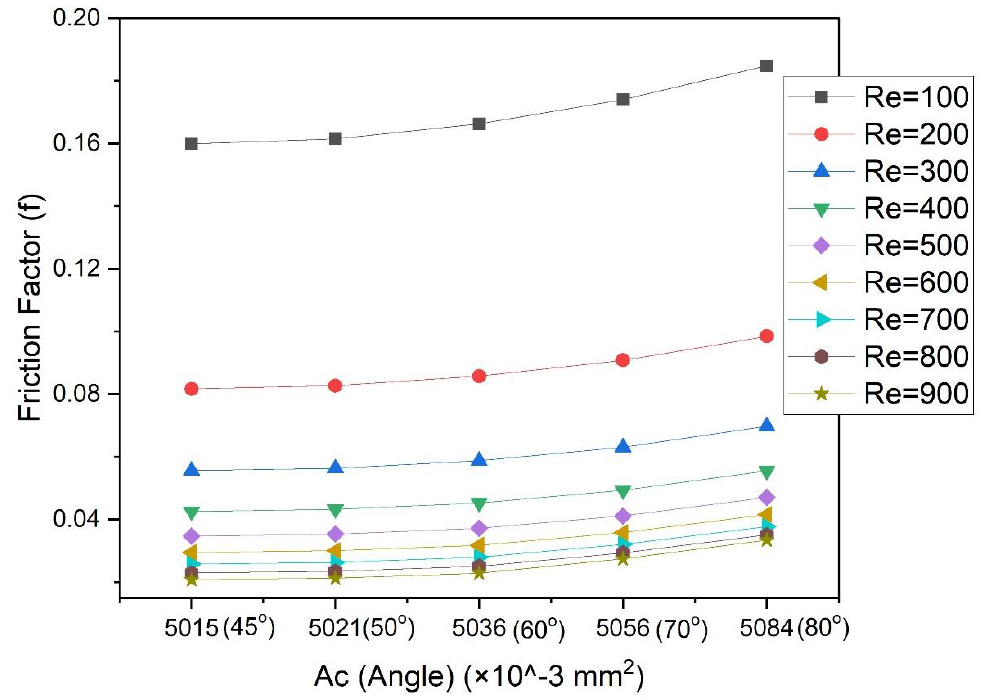
Figure 14. Friction factor variation with heat transfer area at various Reynolds numbers.